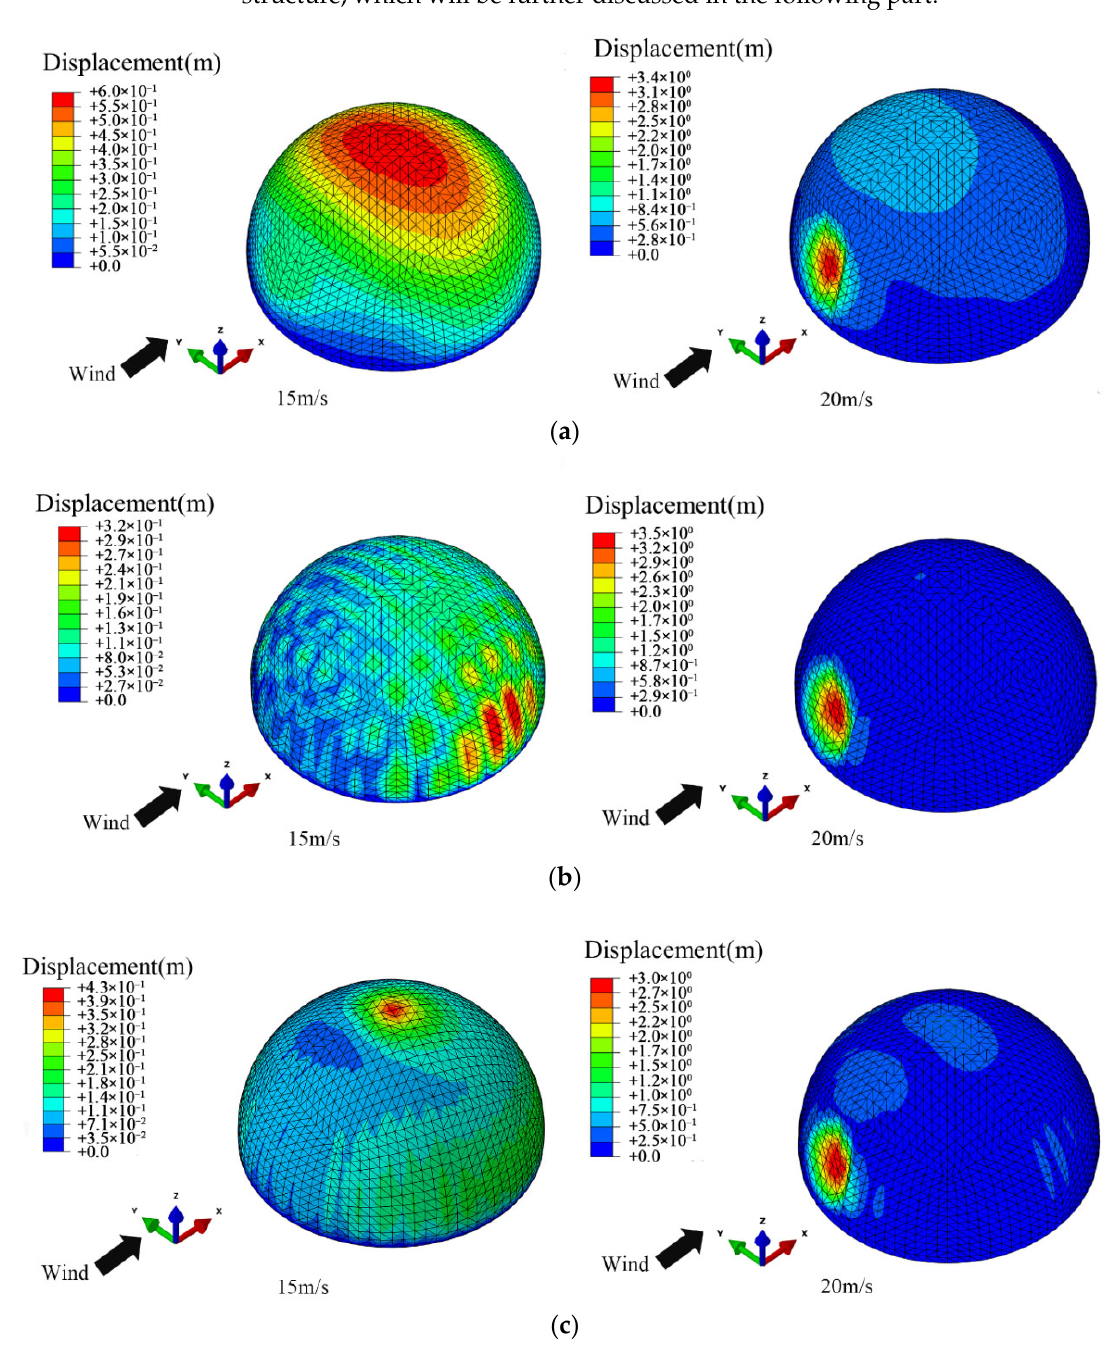
Figure 18. Contours of maximum displacement of structures with different cable configurations ( L = 60 m, H / L = 0.50, p = 300 Pa): ( a ) Without cables; ( b ) Cross cables; ( c ) Radial